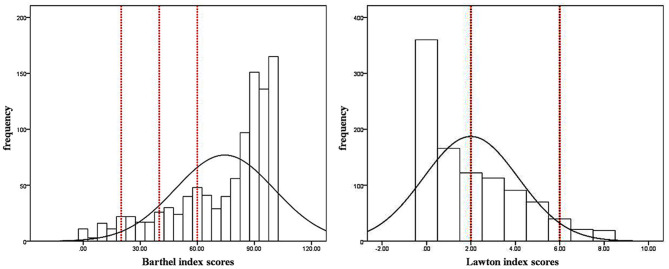
Distribution of Barthel index scores and Lawton index scores in Hainan centenarians. The red dotted lines represent the cut-off value of different degrees of disability.